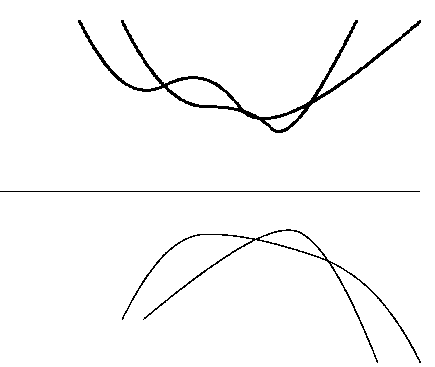
Figure 8 . An economical representation of the relevant information of (cid:12)gure 7 in which we plot for each real k 1 , only the points of the singular loci that have the same Re ( k 1 ). In other words we draw s s a vertical line through (cid:2) in (cid:12)gure 7 and plot only the points where it intersects the singular loci. This allows us to capture the relevant information for all Re ( k 1 ) in one graph instead of having to s plot separate graphs like (cid:12)gure 7 for di(cid:11)erent positions of (cid:2) on the real axis. Since the singular locus always keeps away from (cid:2) in (cid:12)gure 7, in this new representation the curves will never cross the real axis. For reasons to be explained in the text, the curves above the real axis have been drawn thicker than the ones below the real